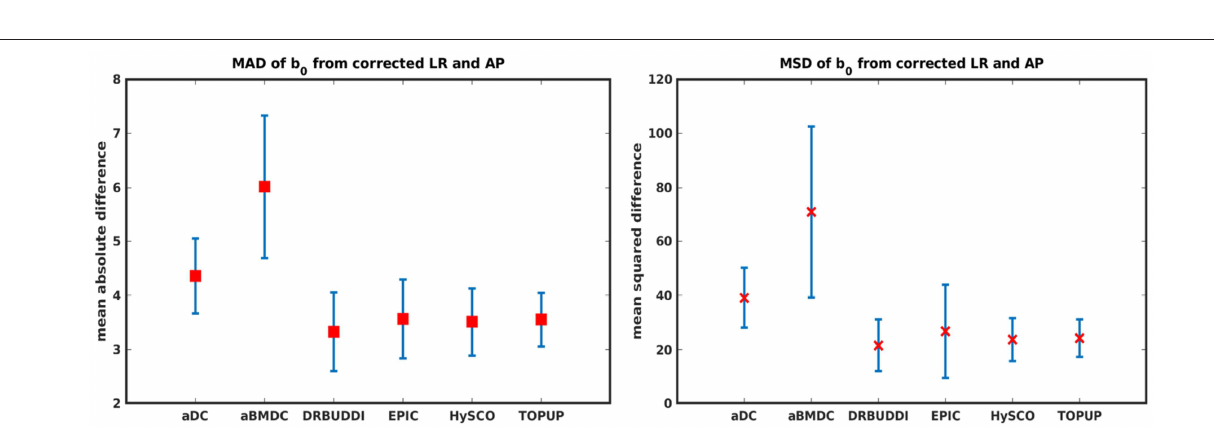
Frontiers in Neuroinformatics |